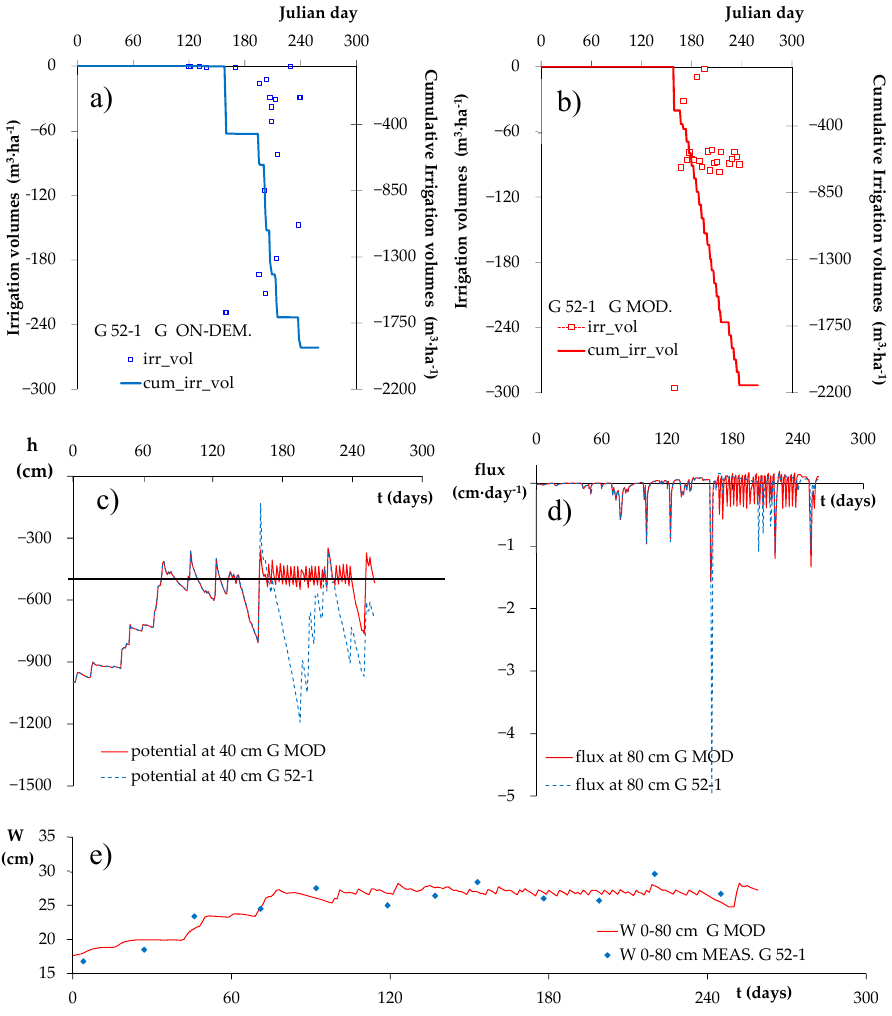
Figure 8. FARM G 52-1. ( a ) The irrigation volumes (both per single day and cumulative) calculated by the model (MOD); ( b ) the irrigation volumes actually supplied by the farmer (ON-DEM); ( c ) the pressure head at 40 cm depth; ( d ) the percolation fluxes at 80 cm; ( e ) comparison between the time evolution of the water storage predicted by the model (MOD) and that estimated starting from the EMI sensor ECa readings (MEAS).